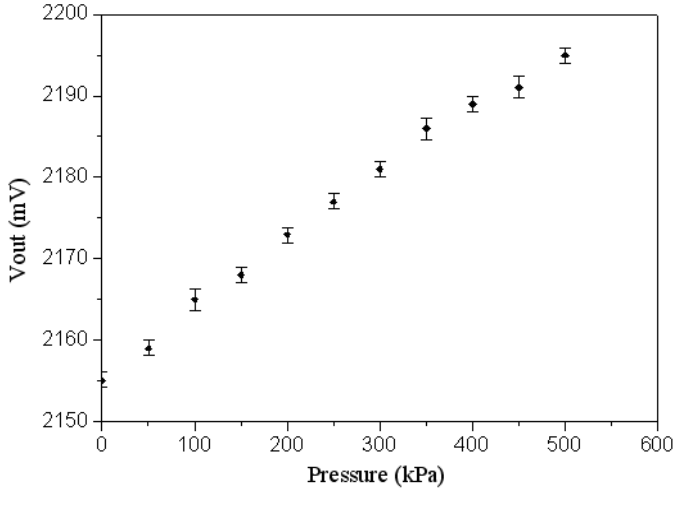
Figure 12. Measured results of the output voltage in the pressure sensor.